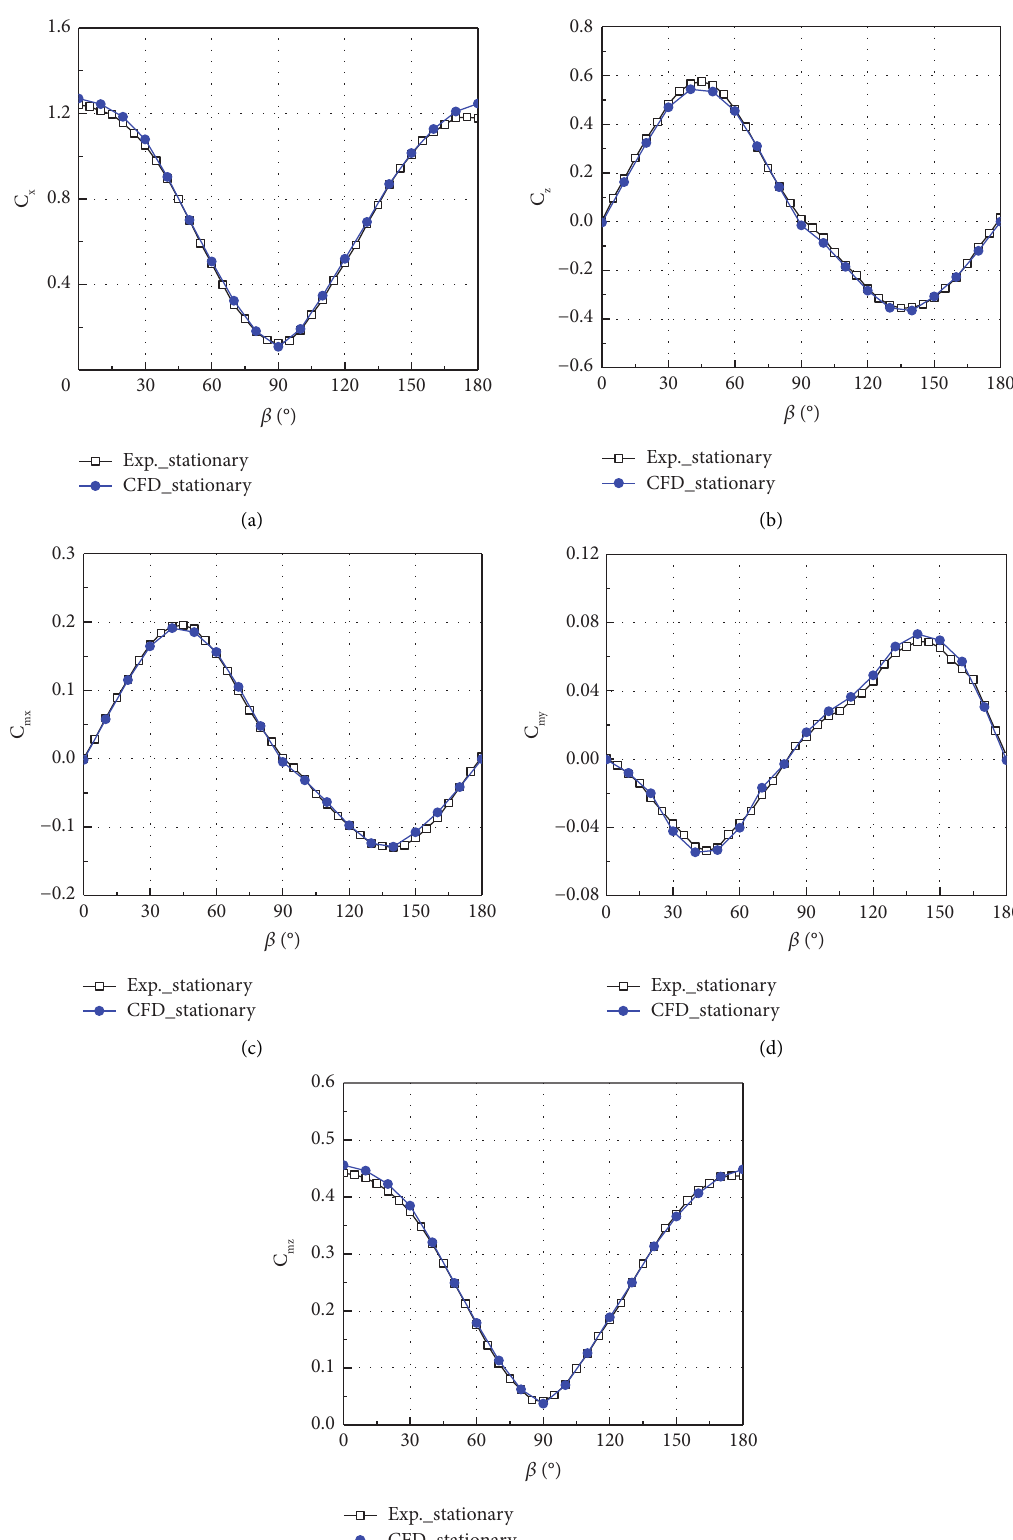
Figure 16: Wind tunnel test results and numerical simulation results of aerodynamic coefficient with respect to the azimuth angle when the antenna is at rest (porous plate, β � 0–180 ° ). (a) C x − β , (b) C z − β , (c) C mx − β , (d) C my − β , and (e) C mz − β